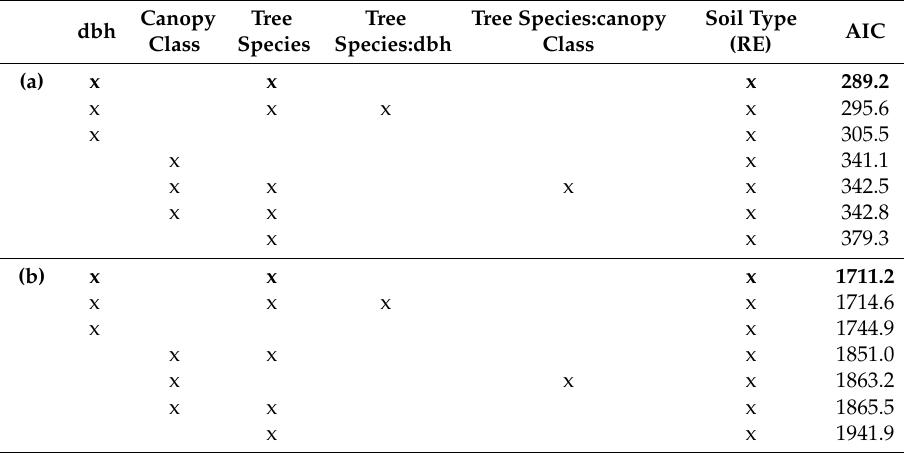
Table 2. Fixed and random effects (RE) and AIC result of LMERs (a) and GLMERs (b) for microhabitat diversity per habitat tree (x = included effect; bold = model with the lowest AIC).